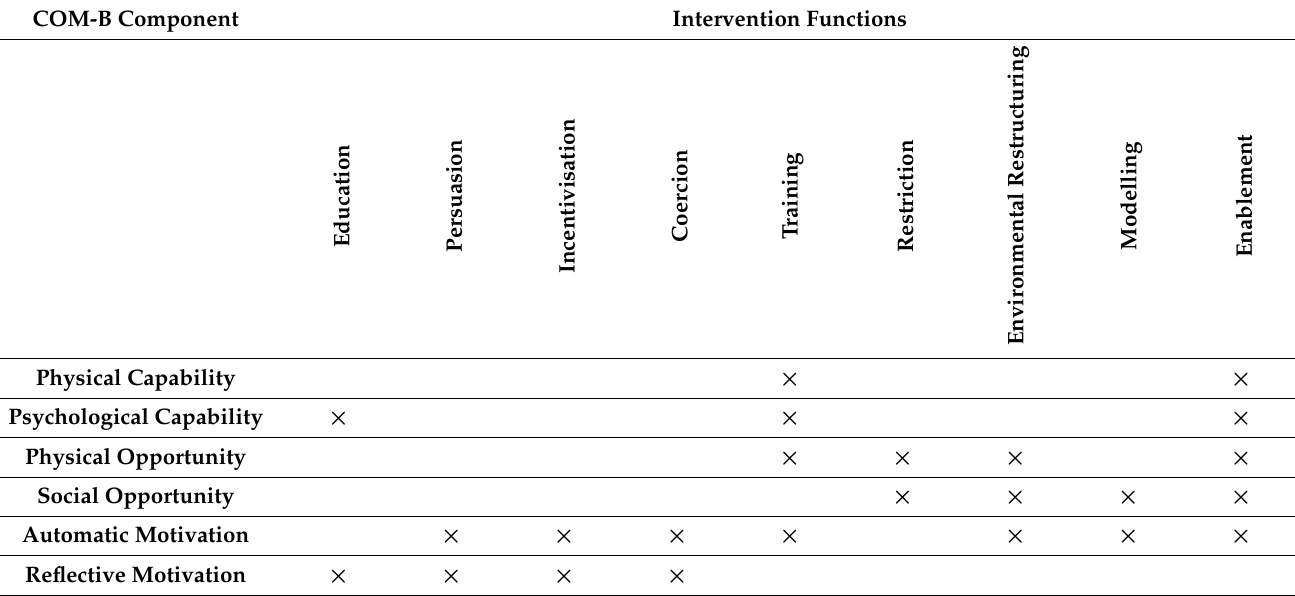
Table 1. Relationship between the COM-B components and the BCW intervention functions. Crosses ( × ) indicate intervention functions that are more likely to have an influence on COB-B components. COM-B Component Intervention